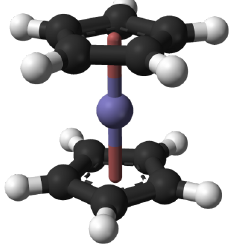
Figure 6. Ferrocene molecule as a representative of the general structure of metallocenes. Two cyclic organic molecules (ligands) bind to the central metal atom. In the center is the iron atom (blue), the carbon atoms are black and hydrogen atoms are white